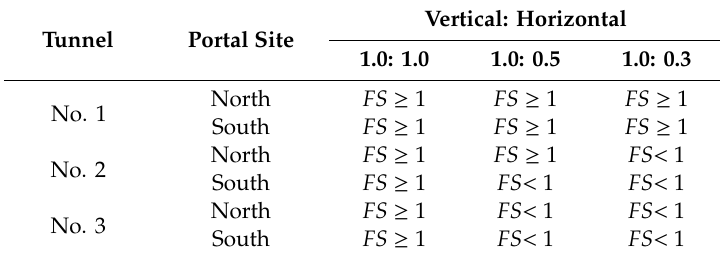
Table 2. Analysis results for stability of excavation slope at portal